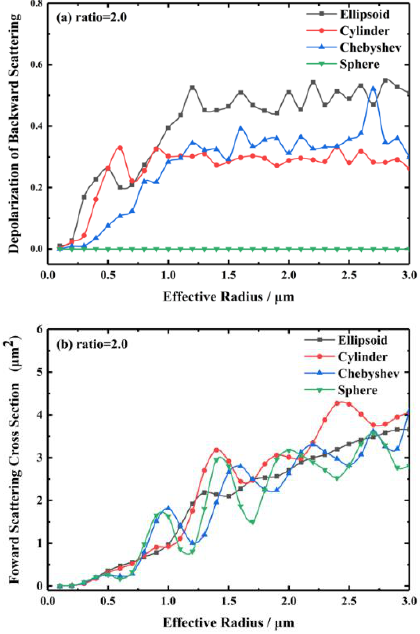
Figure 6. The relation between mean deviation of particle depolarization ratio and particle equivalent radius in receiving